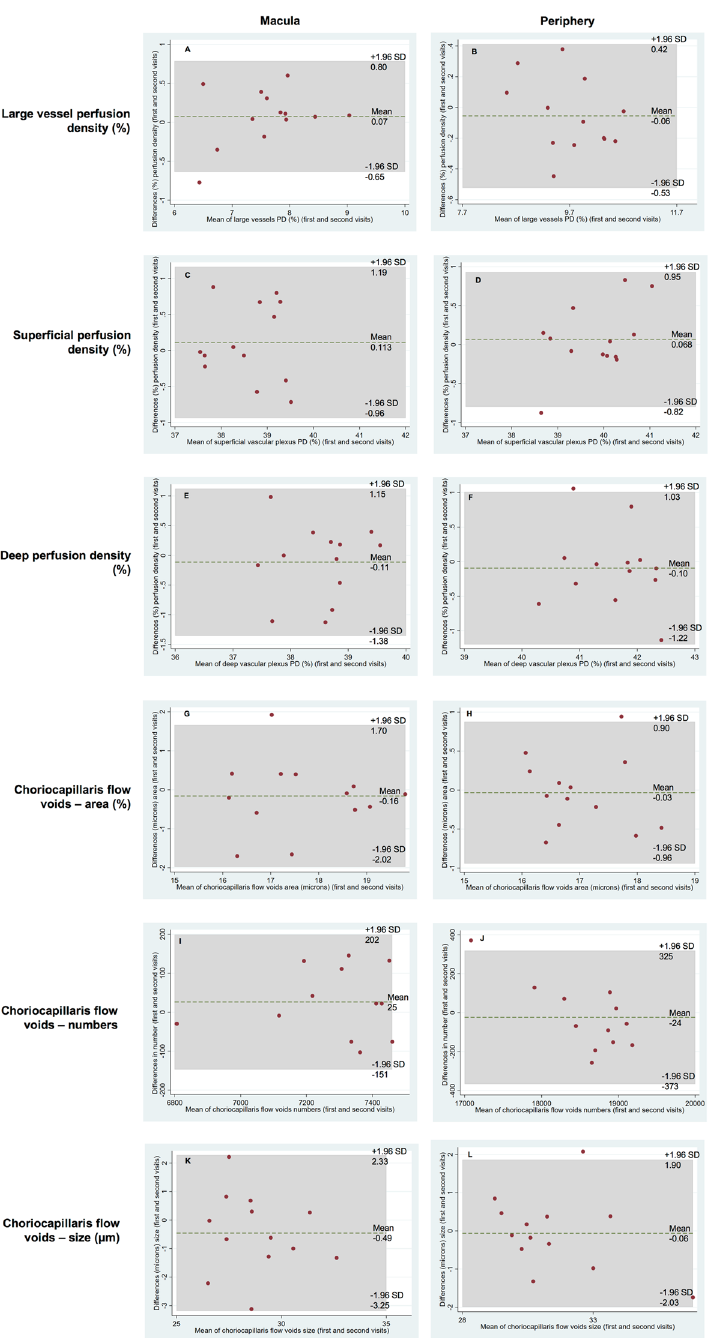
Figure 4. Bland–Altman plots of the different retinal and choriocapillaris flow void